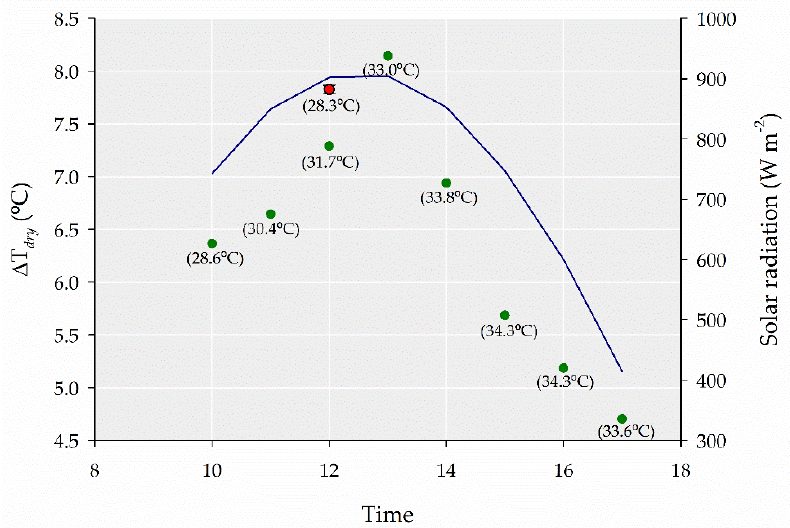
Figure 6. Daytime evolution of mean solar radiation (blue straight line) and mean ∆ T dry values (green symbols), derived with Equation (3) using hourly mean T a values (numbers in brackets below each symbol) measured during the experimental periods of 2017–2019. Mean ∆ T dry values measured at midday in senescent (non-transpiring) maize plants during the 3rd–7th of September 2018 are also plotted (red symbol).